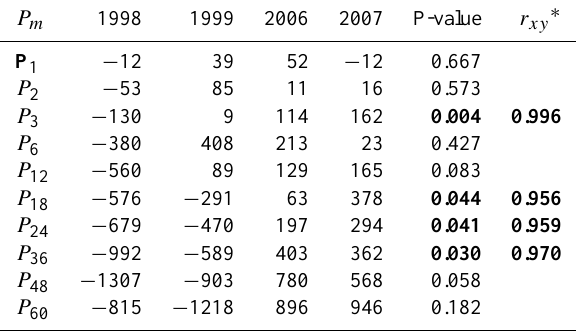
Table 5. Precipitation/groundwater relative contribution correlation results to Querococha discharge for the 1998, 1999, 2006, and 2007 dry seasons. Normalized precipitation, P m , is the antecedent pre- cipitation, normalized to the 1982–2007 monthly average, for m months prior to the month of July. Normalized precipitation is ex- pressed in mm. r xy is the correlation coefficient for the q gw / q gl ratios and the normalized precipitation. Only the statistically repre- sentative r xy are